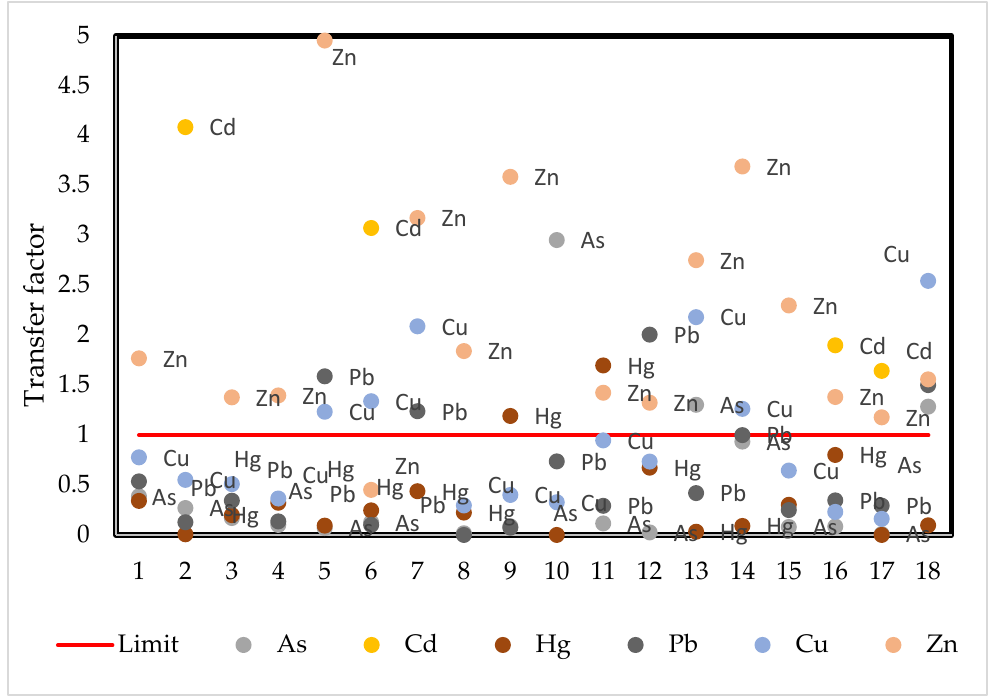
Figure 5. Transfer factor for leaves-soil. The red line represents the limit above which metals are observed to be able to be transferred in the plant.